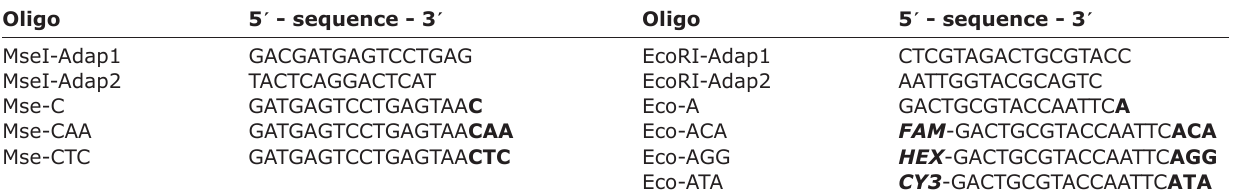
Table-1: Sequence 5 ´ - 3 ´ of primers and adaptors used to establish the AFLP-PCR technique according to the original protocol of Vos et al. [14]. Oligo